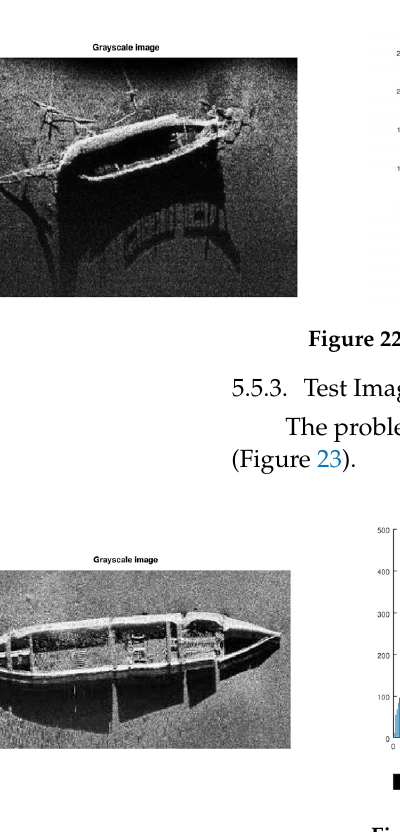
Figure 23. Results for test image